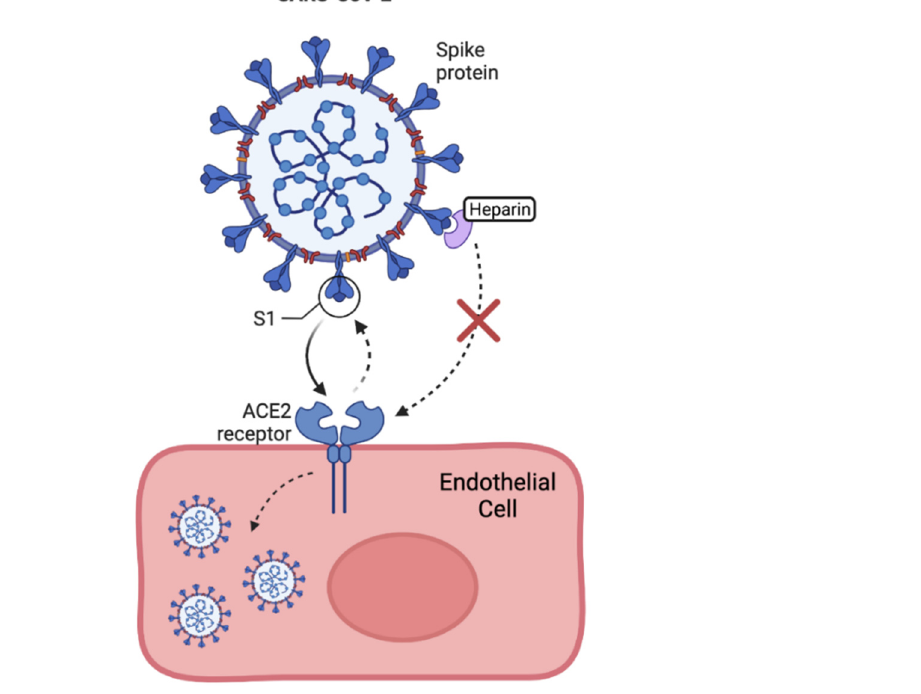
Figure 5. Prophylactic role of heparin in COVID-19 pathophysiology: Binding of low-molecular- weight heparin to the S-protein prevents binding of the S-protein to ACE2 preventing SARS-CoV-2 entry into the host cell and subsequent infection.